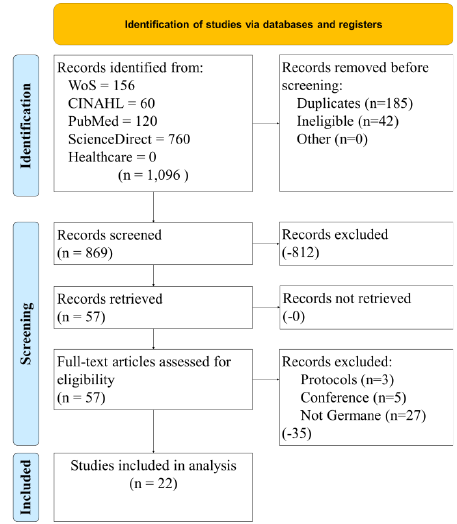
Figure 1. Study selection process.